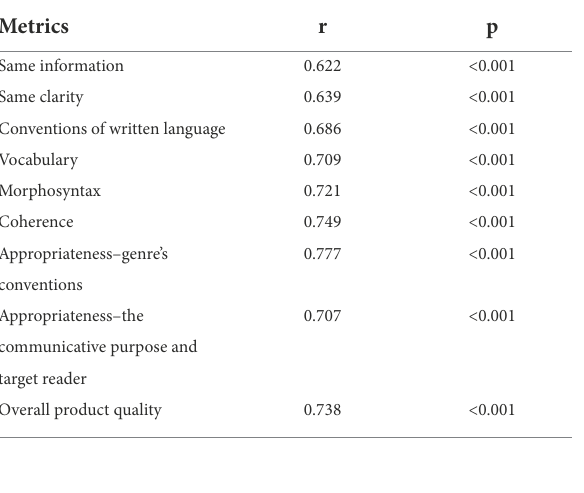
TABLE 2 Comparative analysis of the correlation in product quality between translation and paraphrasing in each metric.